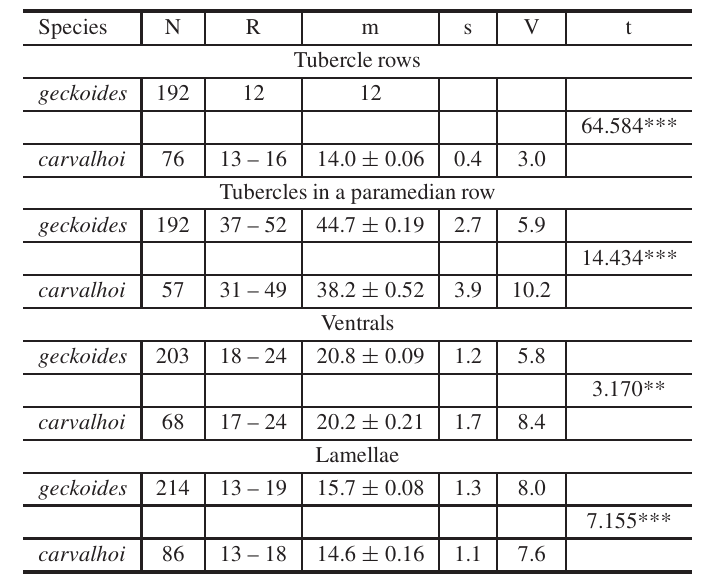
Gymnodactylus carvalhoi and G. geckoides, comparison of meristic characters.